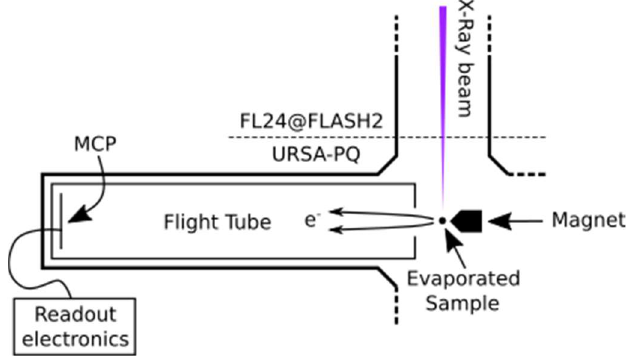
Figure 5. Sketch of the experimental setup. The soft X-rays from FLASH2 are focused into the interaction region of the magnetic bottle spectrometer, where the sample is provided by means of a capillary oven (located above the spectrometer, out of plane of the diagram). The emitted photoelectrons enter the flight tube and are detected by an MCP detector.